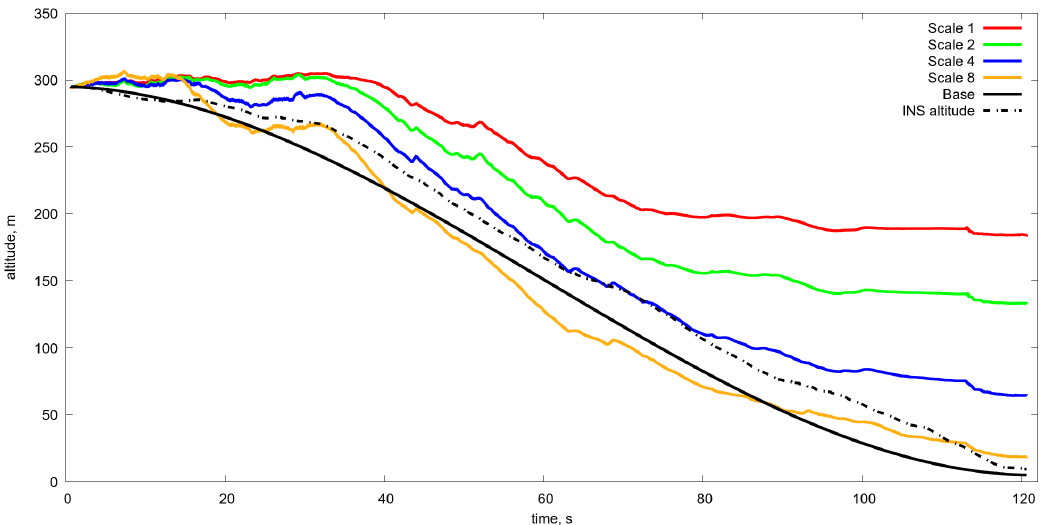
Figure 9. Estimated altitude in comparison with the real one obtained with a various level of resolution with averaging from 1 × 1 to 8 × 8. One can see that only the averaging 8 × 8 gives the acceptable accuracy of the altitude estimation in the range from 300 m to 50 m. Scale 1, 2, 4, 8 estimated altitude obtained by optical flow and Kalman filtering with different level of averaging, namely from 1 to 8. Base is the program motion. INS is the altitude from the inertial navigation